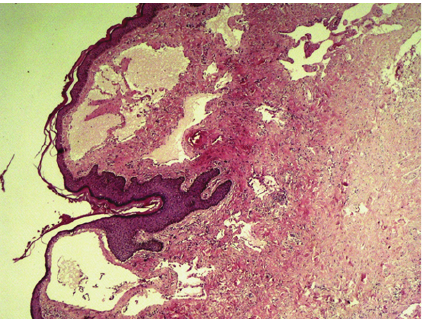
Figure 5: Dilated lymphatic channels containing eosinophilic pro- teinous material in the upper epidermis (HE, ×